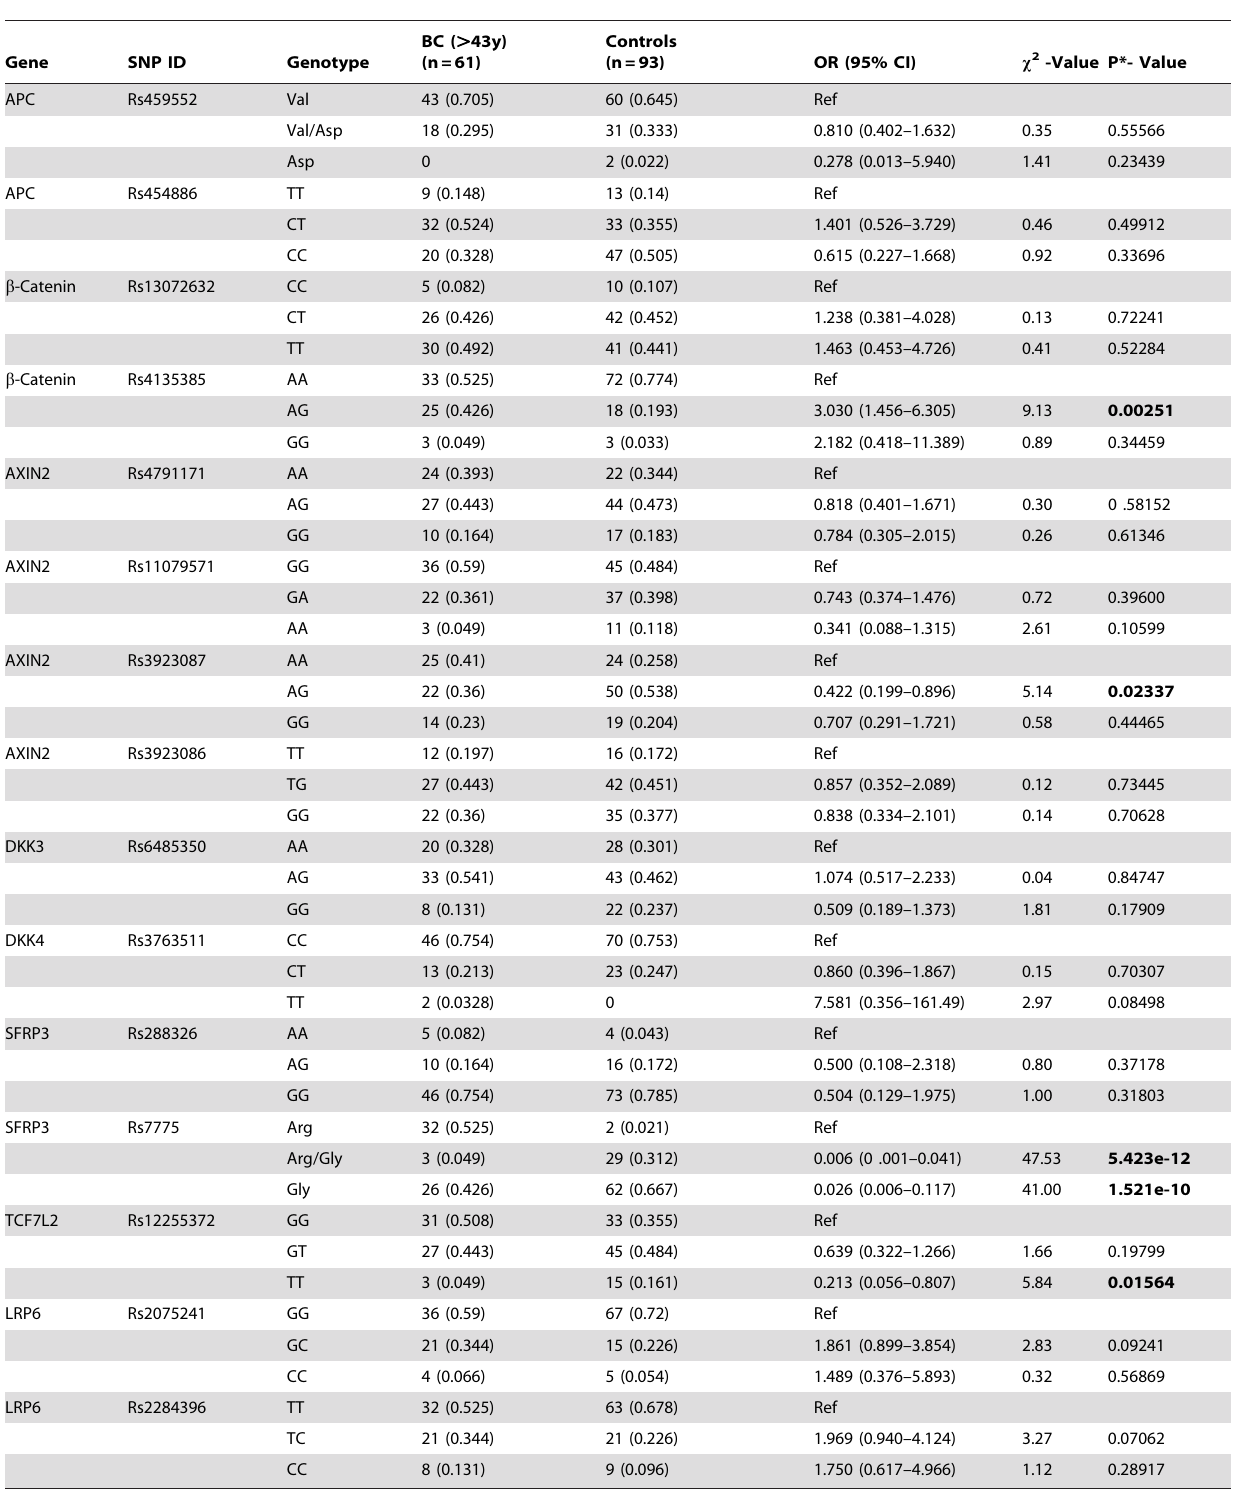
Table 4. Comparison of genotype frequencies of SNPs in Wnt pathway genes between Breast cancers (patients age . 43 years) versus